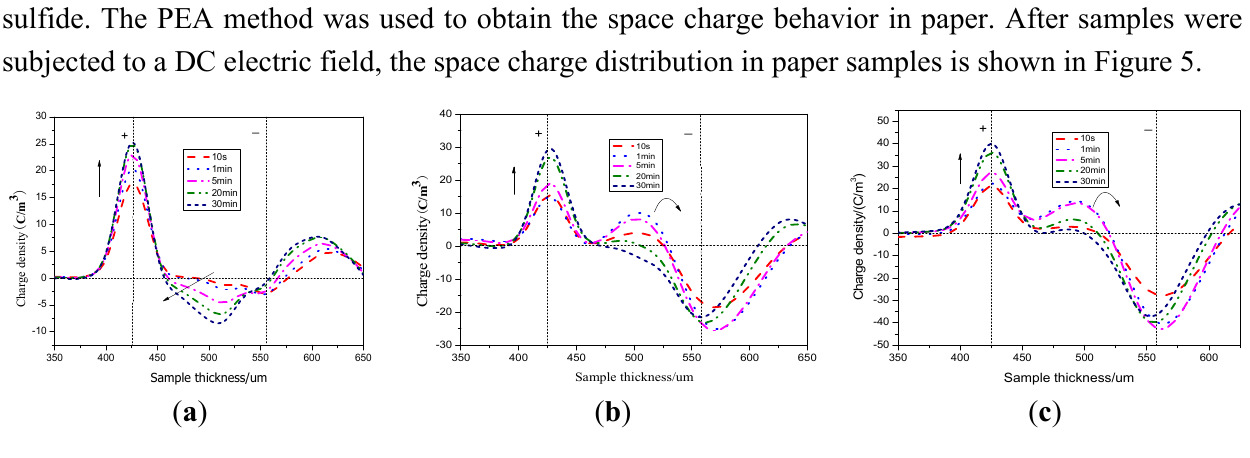
Figure 5. Volt-on space charge distribution of paper samples: ( a ) sample I; ( b ) sample II; and ( c ) sample